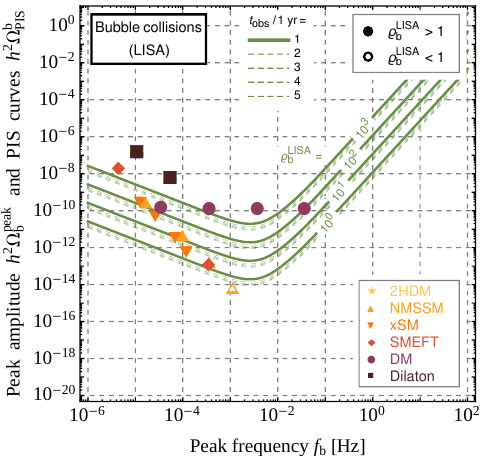
Figure 5 . PISC for LISA in the b-channel for different values of % thr and t obs . See eq. (3.9).